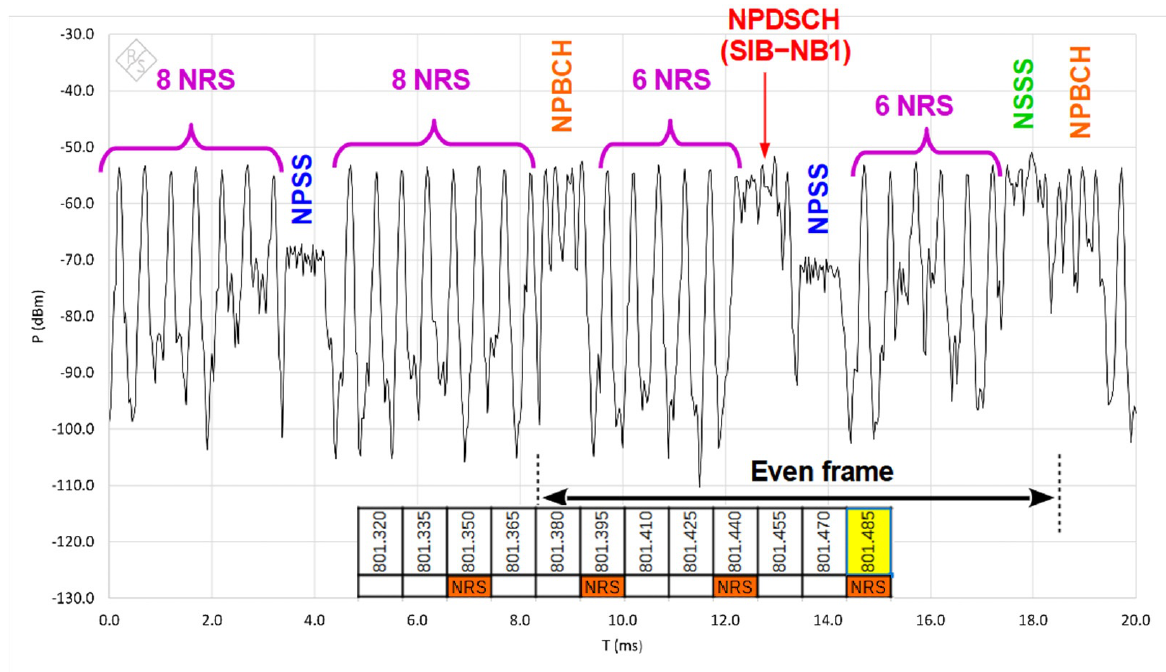
Figure 9. Example of time acquisition of last subcarrier (801.485 MHz).